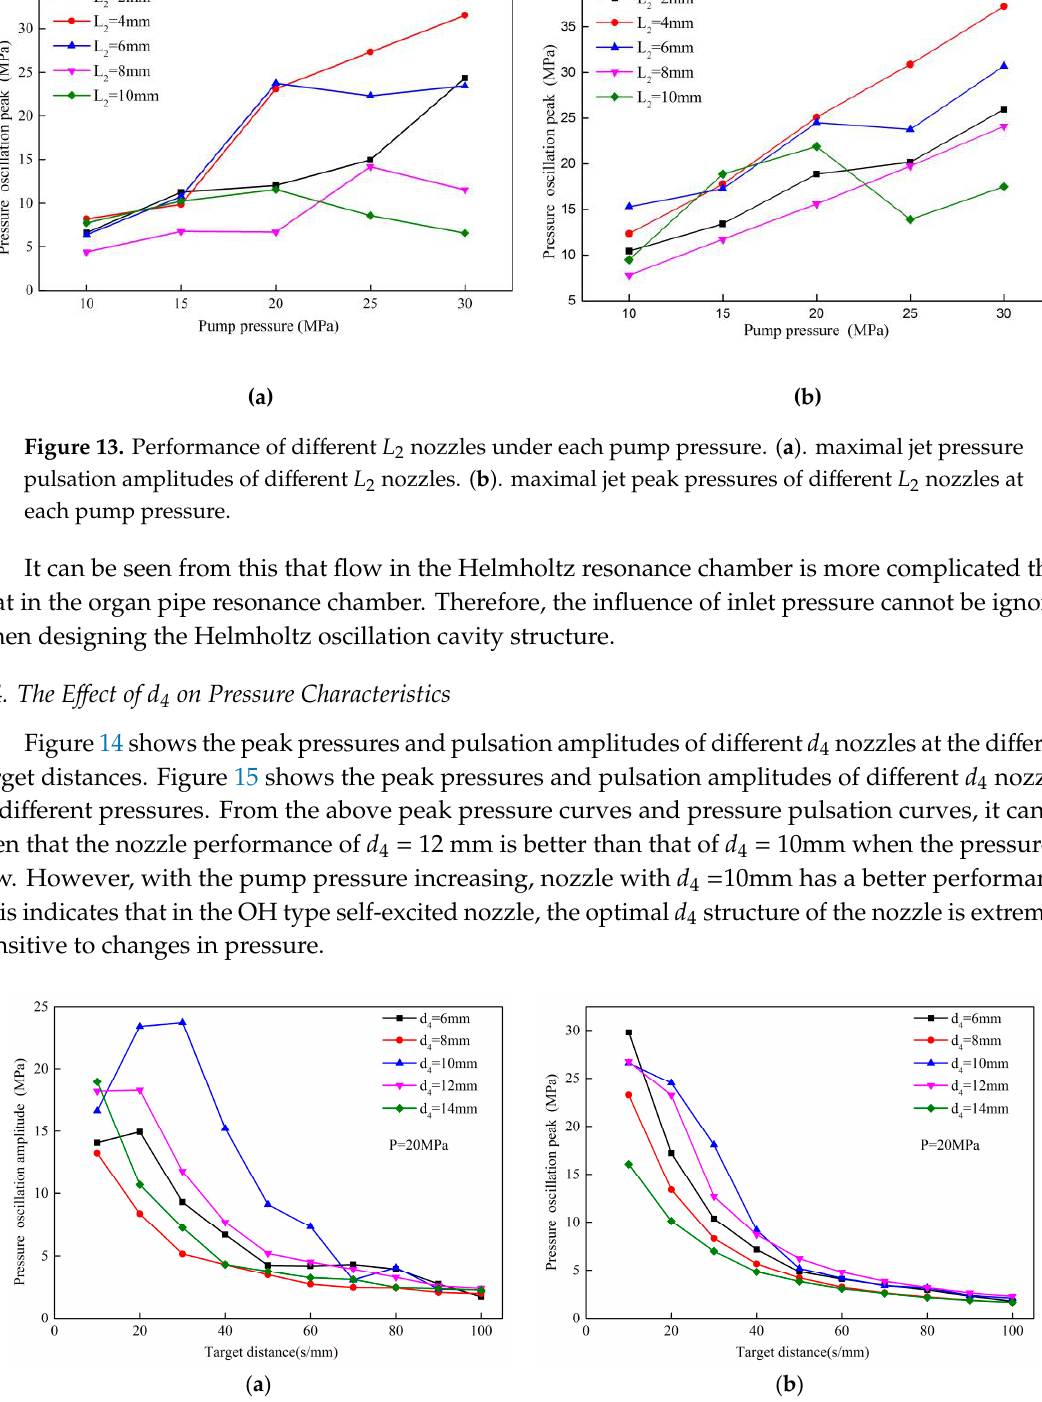
( b ) Figure 15. Performance of different d 4 nozzles under each pump pressure. ( a ). maximal jet pressure pulsation amplitudes of different d 4 nozzles. ( b ). maximal jet peak pressures of different d 4 nozzles at each pump pressure. For the Helmholtz nozzle, the vortex ring modulation coupling of the downstream collision wall feedback is mainly affected by d 4 . If the cavity diameter is too small, the jet will form a reflux vortex when it engulfs the surrounding fluid in the chamber and cannot be fully developed. This causes the chamber wall to be subjected to limited compression against the backflow of the chamber, resulting in increased energy consumption. If the cavity diameter is too large, the vortex is fully developed and the return flow is away from the jet axis, and the axial jet cannot be effectively modulated and coupled. So d 4 = 12 mm nozzles have better performance when the pressure is lower. When the pressure is 20 MPa or more, the pulsation amplitude of the pressure produces a maximum at d 4 = 10 mm. 4.5. The Effect of d 3 /d 5 on Pressure Characteristics Figure 16 shows the effects of d 3 / d 5 on the peak pressure and pressure pulsation amplitude of the OH self-excited pulse nozzle at the different target distances. Figure 17 shows the effect of d 3 / d 5 on the peak pressure and pressure pulsation amplitude of the OH self-excited pulse nozzle at different pressures. As can be seen from the two pictures, the jet peak pressure increases as the nozzle diameter increases at first, and then decreases. When the nozzle diameter ratio value is 1.0, the jet pulsation peak is the largest. The pressure pulsation amplitude of the jet shows a more sensitive change. When d 3 / d 5 value is 0.5, the pressure pulsation amplitude is almost 5 MPa or less and keeps steady with the pump pressure’s increases. It indicates that the fluid does not oscillate when passing through the